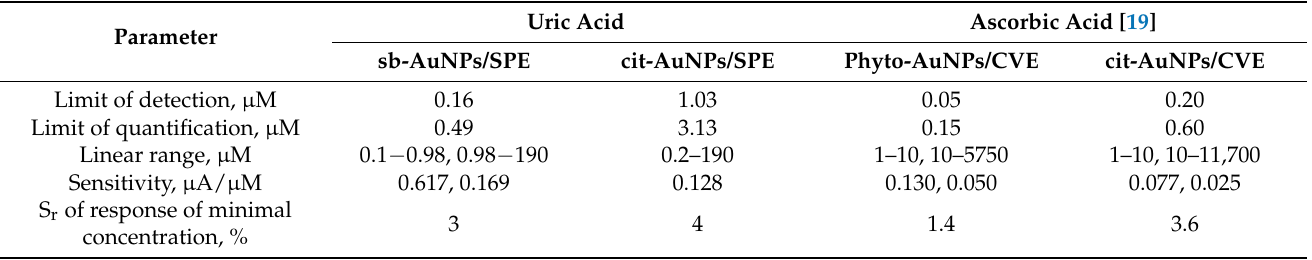
Table 5. A comparison of the analytical characteristics of the electrodes modified with sb-AuNPs and cit-AuNPs and used to detect UA and AA under model conditions by